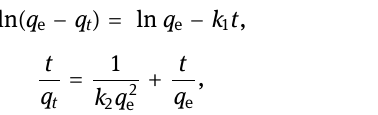
Figure 5: Adsorption kinetics of SO 42− adsorption by ET2.0.